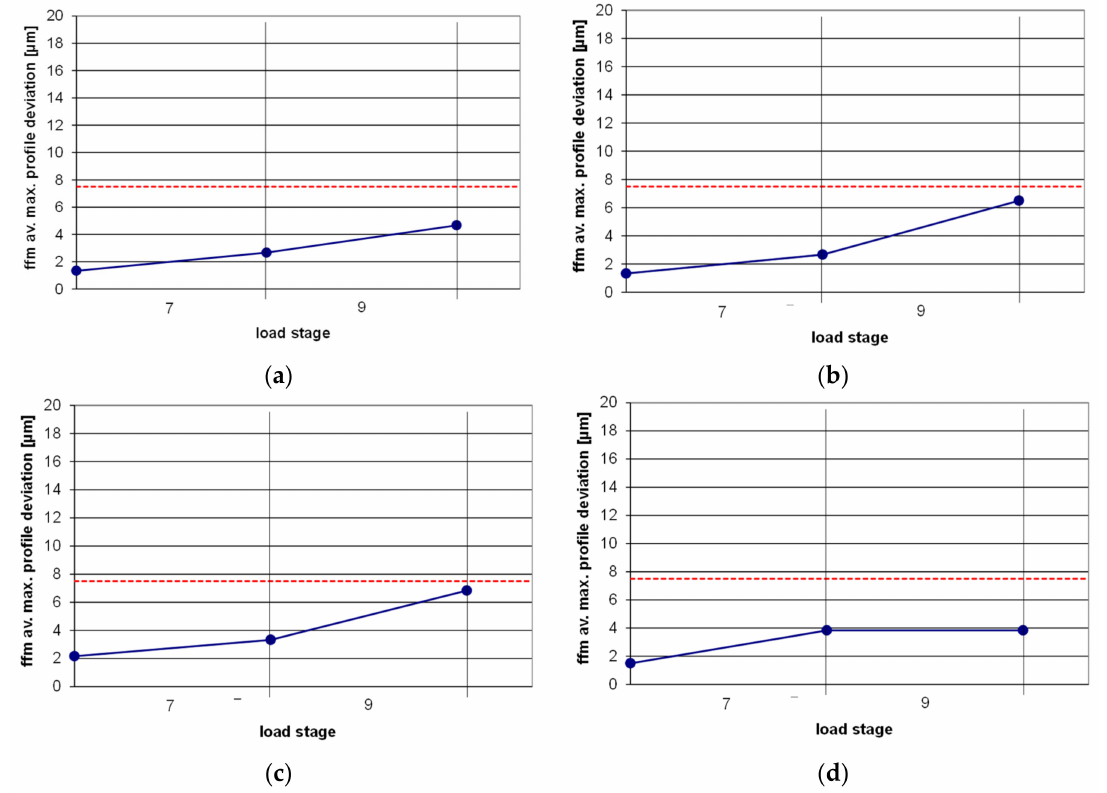
Figure 4. Micropitting test results for PAO: ( a ) fresh oil; ( b ) oil aging stage I; ( c ) oil aging stage II; ( d ) oil from the